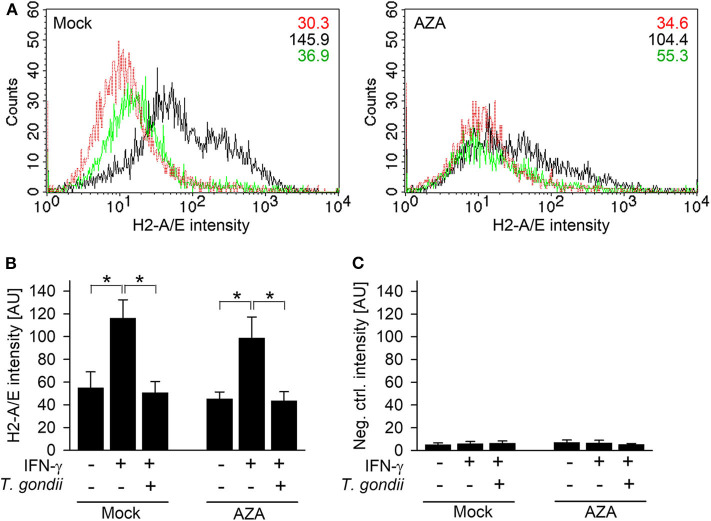
T. gondii blocks IFN-γ-induced MHC class II expression irrespective of inhibition of DNA methyltransferases. RAW264.7 cells were treated with 5-aza-2-deoxycytidine (AZA) for 7 days, before being infected with T. gondii and/or activated with IFN-γ. Surface expression of MHC class II was determined at ~42 h p.i. by flow cytometry, after fluorescence staining of cells using H2-A/E-specific antibodies (A,B) or isotype control antibodies (C). (A) Representative histograms of mock- and AZA-treated cells being left non-activated, non-infected (red), IFN-γ-activated (black), or T. gondii-infected and IFN-γ-activated (green); figures within the plots indicate mean fluorescence intensities of the respective cell population. (B,C) Bars represent mean fluorescence intensities ± S.E.M. from five biological replicates; significant differences between groups were identified by ANOVA (*p < 0.05).